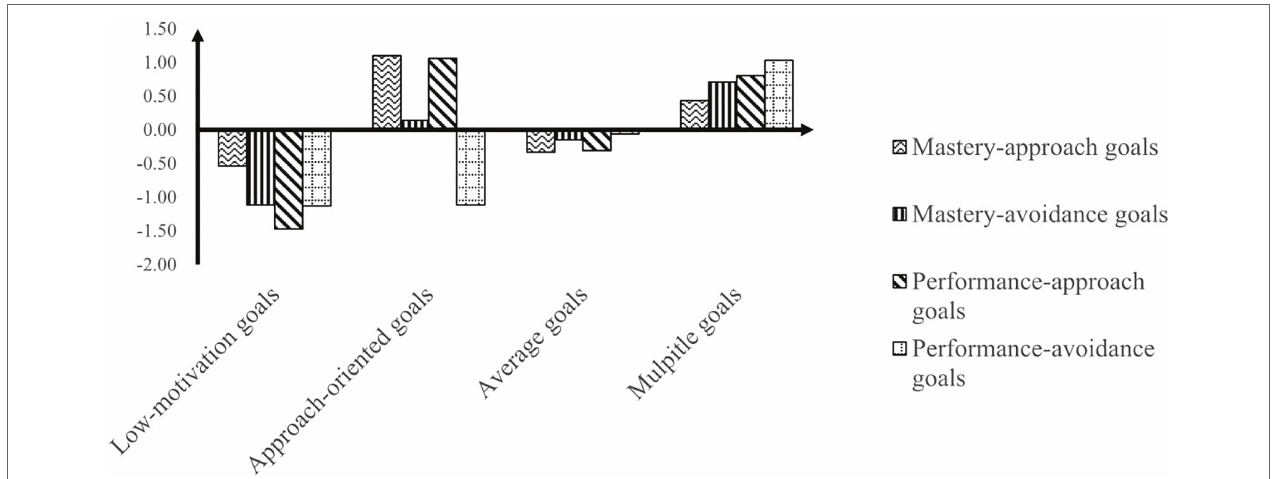
FIGURE 1 | The standardized mean scores on achievement goal orientations across four profiles.